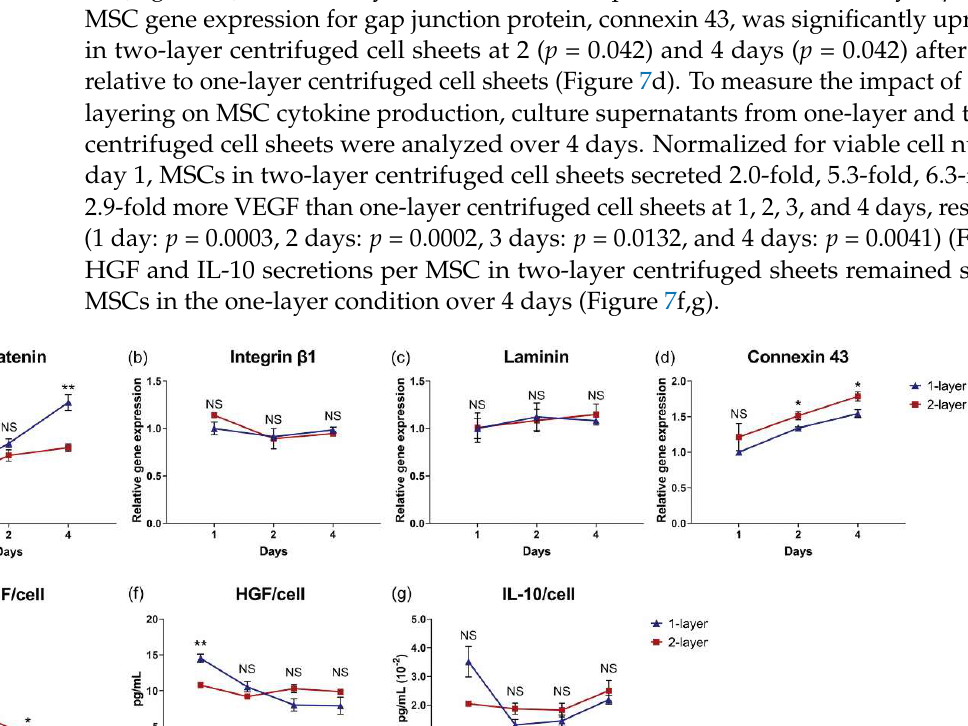
Figure 6. Centrifugation layering enhances MSC pro-regenerative cytokine production related to cellular interactions. Quantitative gene expression of cell interaction proteins ( a ) β-catenin, ( b ) con- nexin 43, ( c ) integrin β1, and ( d ) laminin α5 (ECM), and cytokines ( e ) VEGF, ( f ) HGF, and ( g ) IL-10 in 2-layer conventional and centrifuged cell sheets at 24 h. Analysis of cell sheet supernatants in static culture quantified ( h ) VEGF, ( i ) HGF, and ( j ) IL-10 secretion per 2-layer sheet over 24 h, nor- malized for average viable cell number. Gene expression is normalized to GAPDH and compared